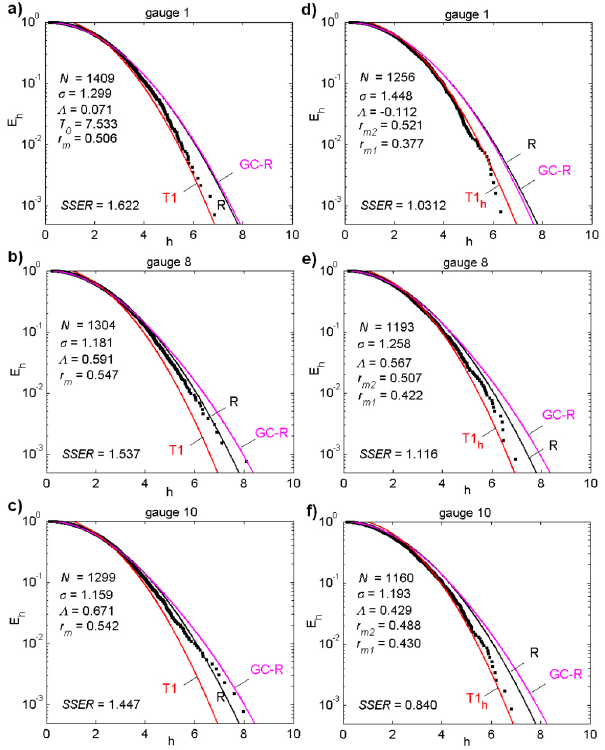
Figure 11. Exceedance distributions of wave heights along the tank for (a–c) test 8230 and (d–f) test